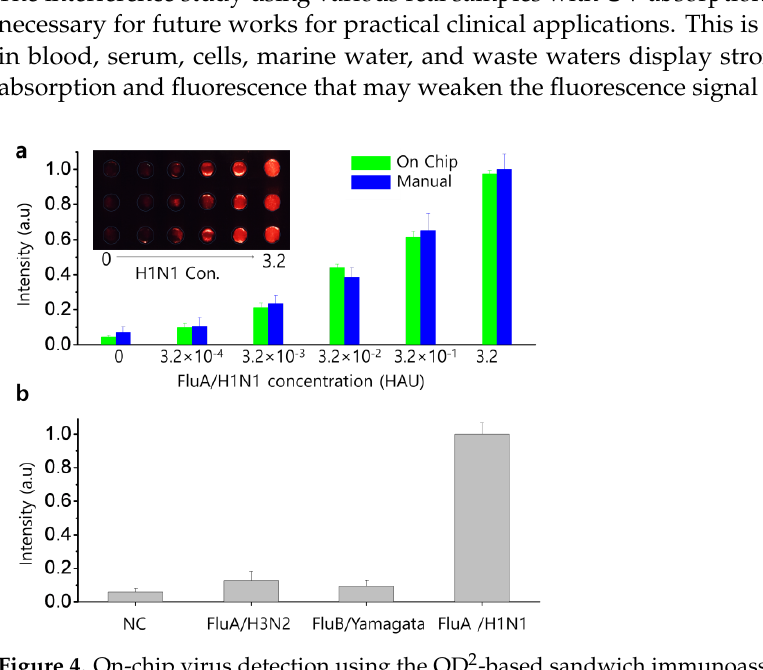
Figure 4. On-chip virus detection using the QD 2 -based sandwich immunoassay. Error bars are S.D. for n = 3. ( a ) Fluorescence-based detection of the influenza A H1N1 virus (FluA/H1N1). Optical intensity quantified by an optical detector (PMT) for the automated device and manual operation. The inset shows a photo of an array with the immune complex under UV light. ( b ) Selectivity of the on-chip immunoassay. The fluorescence intensities are compared between the target virus FluA/H1N1 and nontarget viruses including influenza A H3N2 (FluA/H3N2) and influenza B Yamagata lineage (FluB/Yamagata).